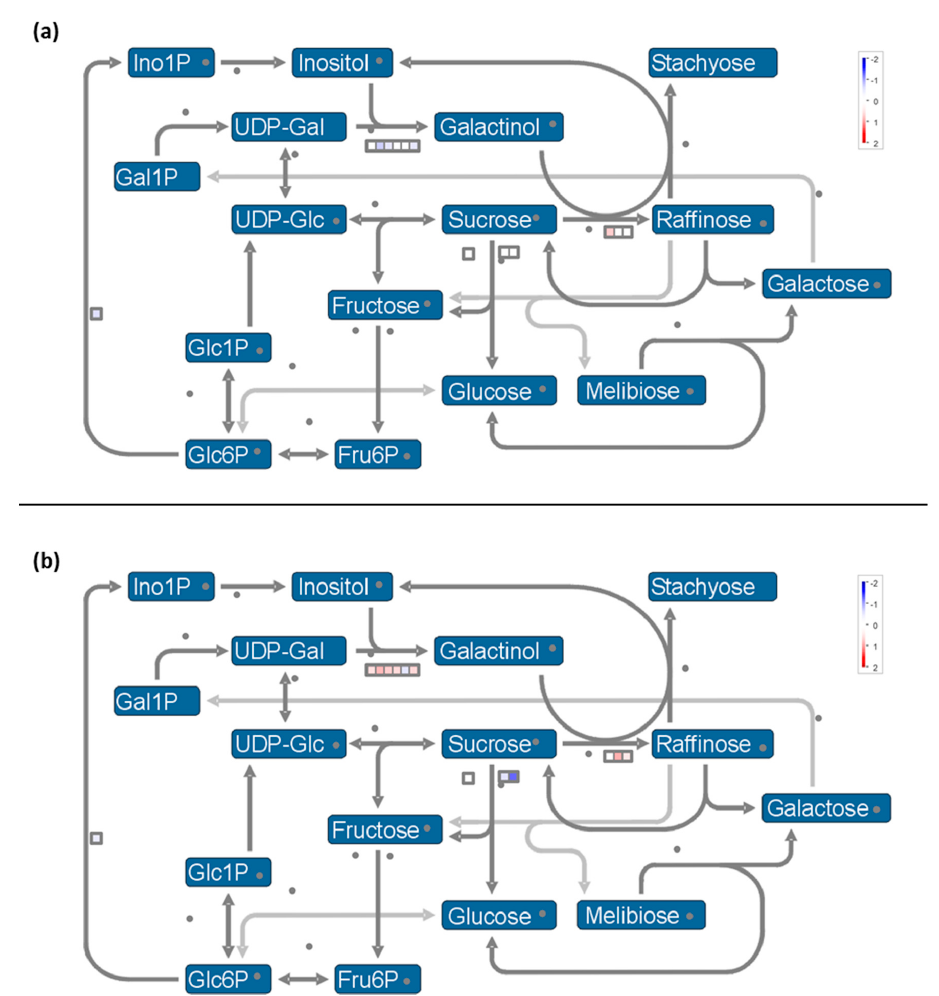
Figure 7. Mapman visualization of raffinose metabolism pathway modulation at ( a ) 8 h and ( b ) 2 h